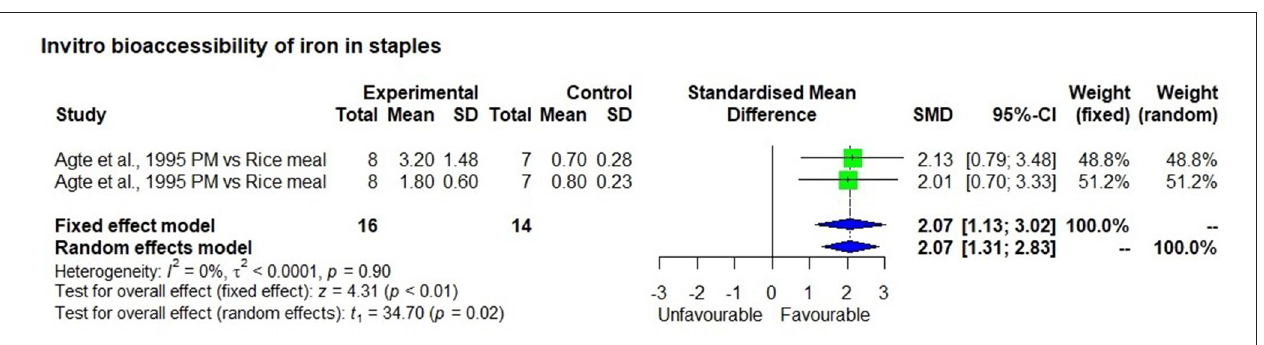
FIGURE 5 | In-vitro bioavailability of iron in millet compared to rice based